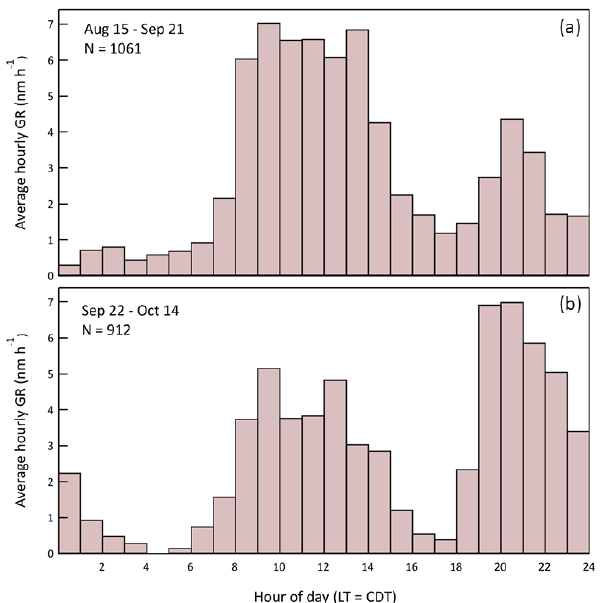
Figure 19. Hourly average particle growth rates during the late sum- mer (a) and early fall (b) portions of the study. A shift in the relative importance of daytime and nighttime growth occurred between the start and end of the